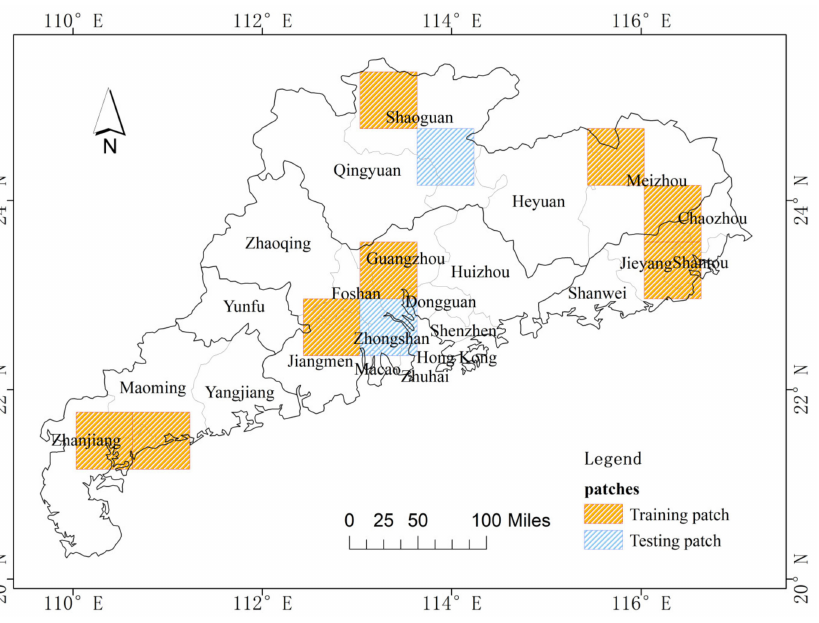
Figure 8. Spatial distribution of training and testing